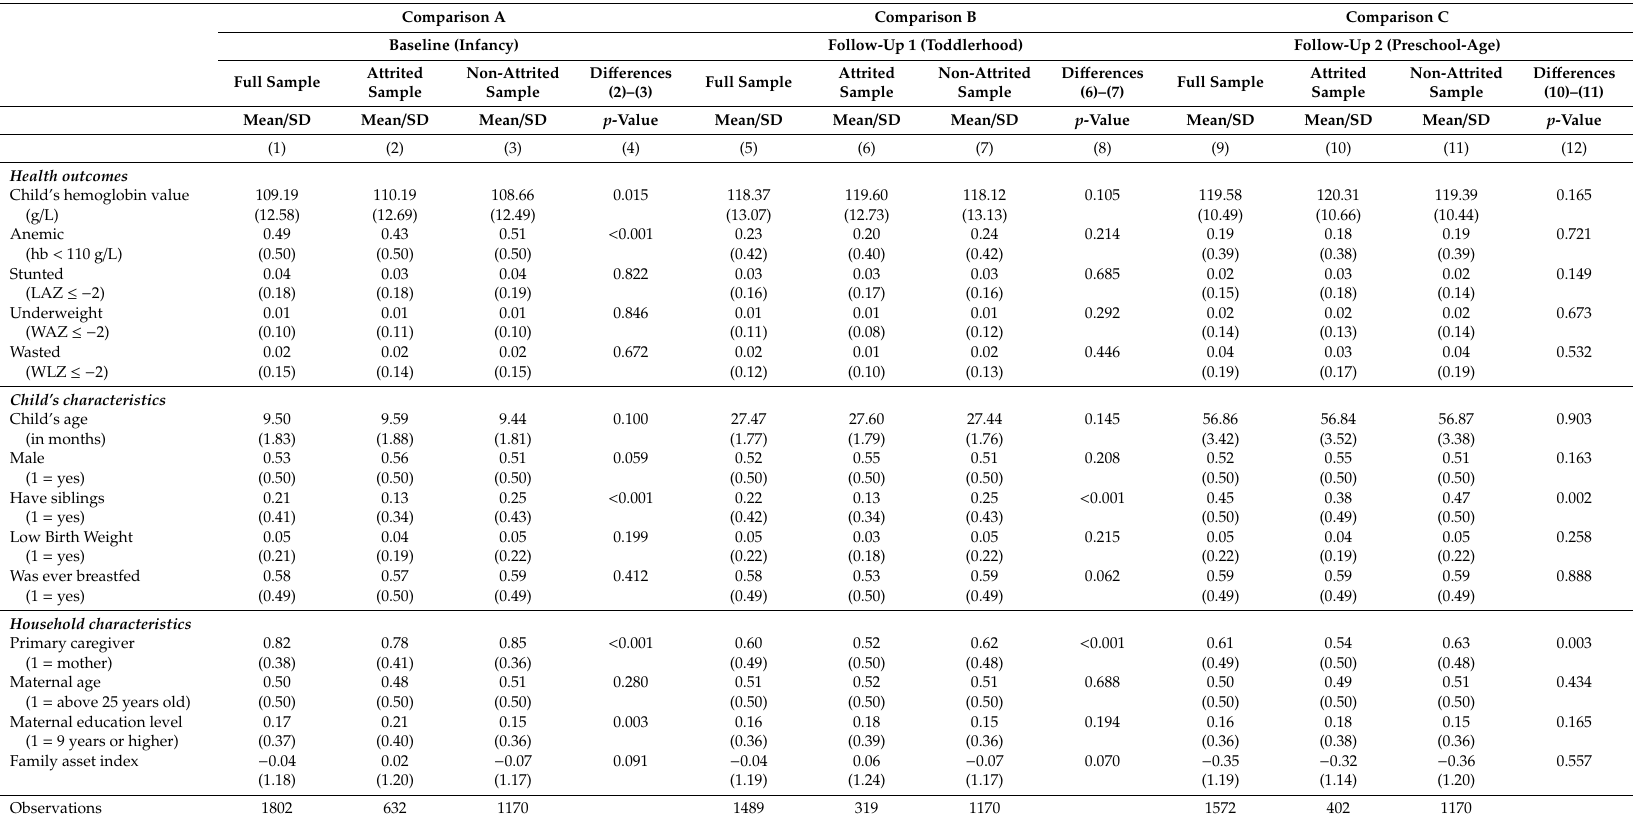
Table A4. Summary statistics of outcomes by attrition